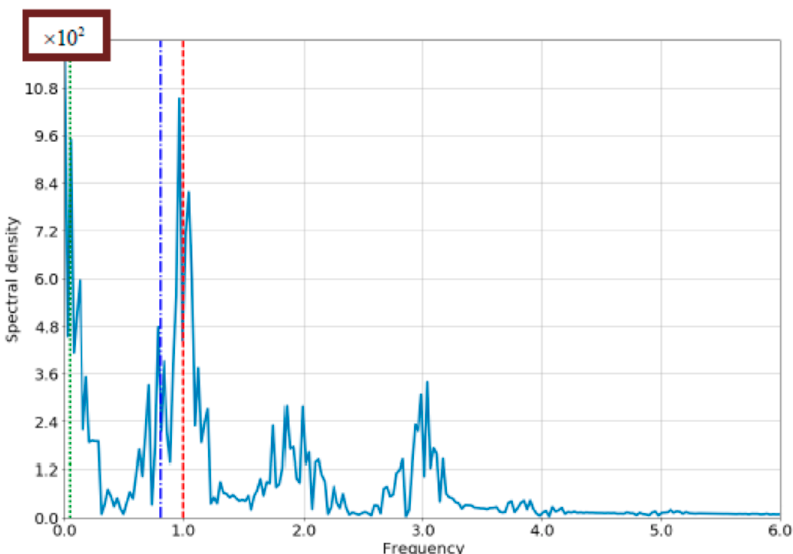
Figure 10. Frequency spectrum of inversion density with RO and BO at the separated frequency ranges at the atomic position j = 90. All parameters are identical to Figure 3.